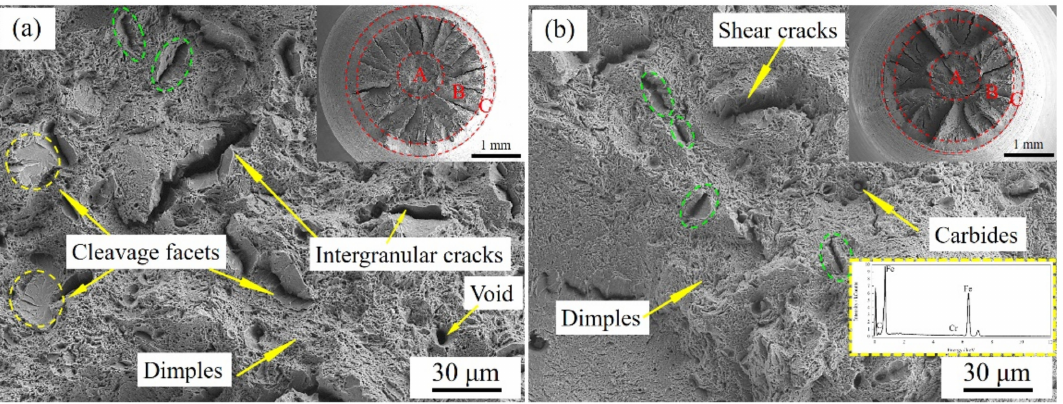
Figure 5. SEM micrographs of the fracture surface A area (in the upper right corner) of tensile samples. ( a ) NT; ( b ) QT. A: fiber region, B: radial region, C: shear lip. The green dashed frame is the secondary